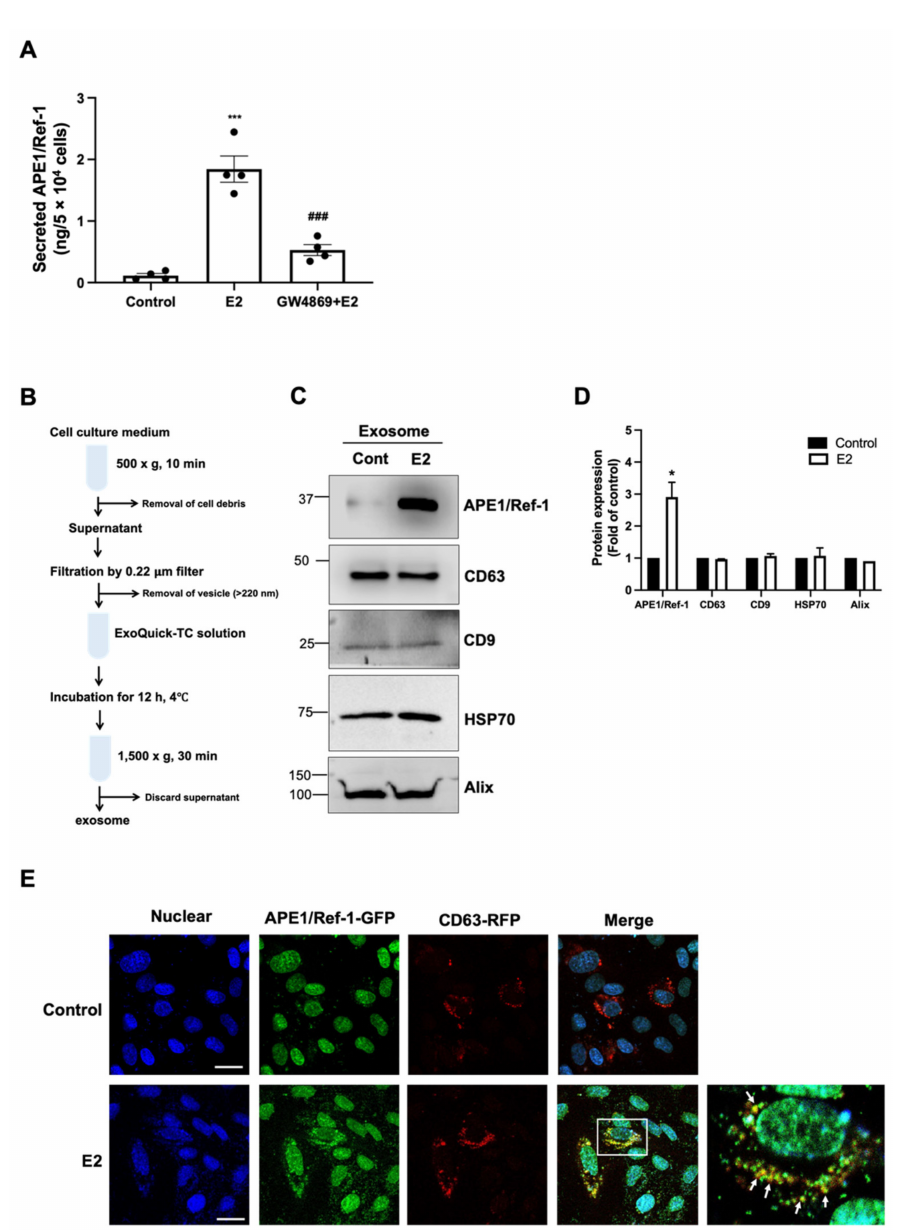
Figure 5. 17 β -estradiol(E2)-induced apurinic/apyrimidinic endonuclease-1/redox factor-1 (APE1/Ref-1) secretion is mediated through exosome pathway. ( A ) 17 β -estradiol-induced APE1/Ref-1 secretion is inhibited by the exosome inhibitor GW4869 (5 µ M). Columns, mean (n = 4); dot plot, SE. *** p < 0.001 and * p < 0.05 vs. control; ### p < 0.001 vs. E2-treated. ( B ) Schematic experimental steps for exosome isolation from the cultured medium of HUVECs. ( C ) 17 β -estradiol (E2) increases APE1/Ref-1 expression in exosomes. Exosome isolation from culture media was confirmed with the presence of exosome-specific markers such as CD63, CD9, heat shock protein-70 (HSP70), and ALG-2 interacting protein X (Alix). ( D ) Summarized data of APE1/Ref-1 or exosome markers expression in exosomes. Columns, mean (n = 4); bar, SE. * p < 0.05 vs. control. Protein expressions are expressed as relative fold of control bands. ( E ) Immunofluorescence image in cultured endothelial cells transfected with plasmid pAPE1/Ref-1-GFP or pCD63-RFP . The images illustrate green fluorescent protein (GFP) fluorescence from APE1/Ref-1 and red fluorescent protein (RFP) fluorescence from CD63. The bottom right photo shows a 2.5 × magnified image of the white box displayed in the merged image. Note, the cytoplasmic APE1/Ref-1 signals (green) are merged with the CD63 signals (red). Arrows indicate typical merged signal (orange). Scale bar showed 100 µ m in length (white